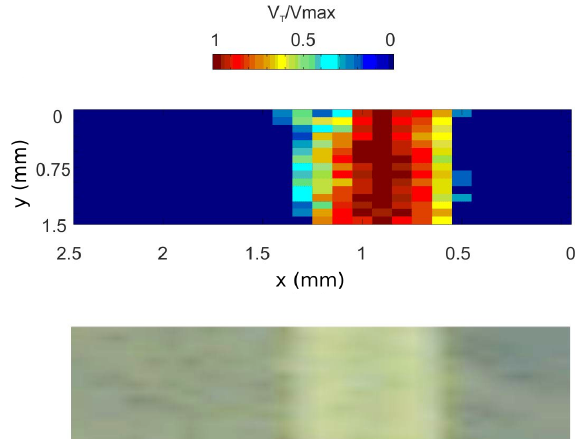
Figure 26. Rat aorta imaging: 2D rat aorta fluid velocity imaging captured by OFI (top image) and raw image of the scanning zone captured by camera (bottom